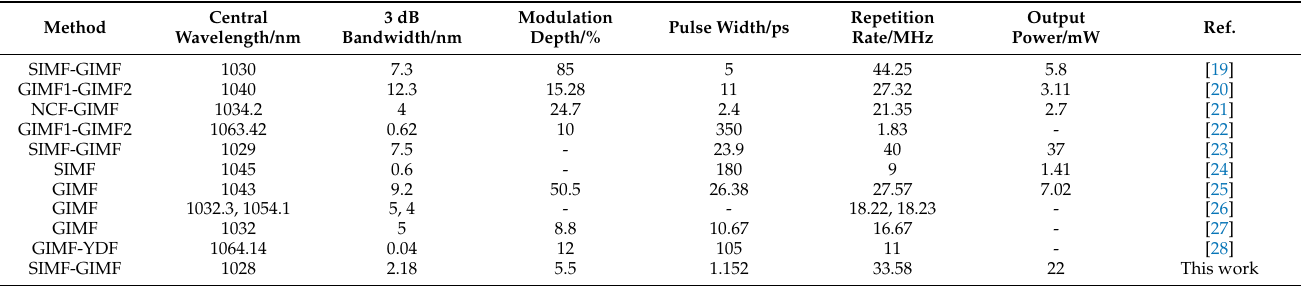
Table 1. Comparison of Yb ‐ doped mode ‐ locked fiber lasers based on NL–MMI.